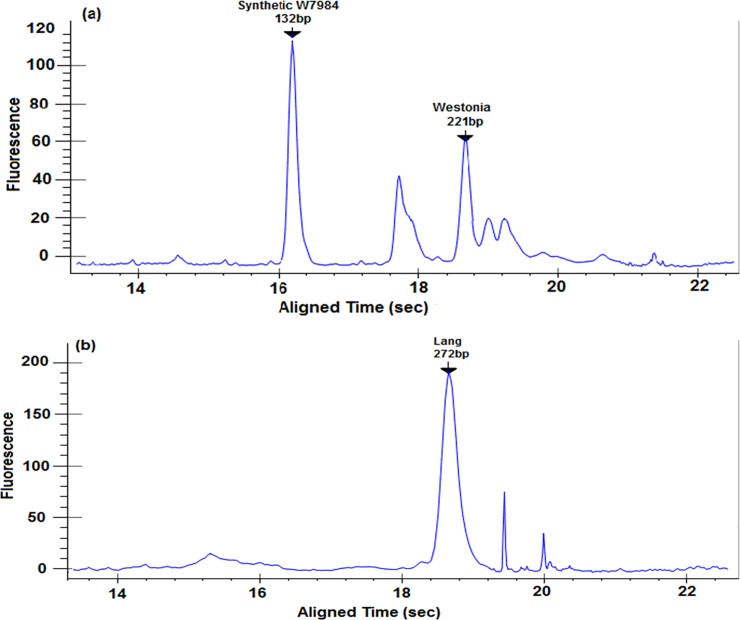
Electropherogram of PCR products of marker Xbarc230 and Xbarc319 from F2:4 Synthetic W7984 × Westonia lines exposed to water stress during meiosis.The calculated molecular weight (bp) of PCR product (peaks) is displayed, the black arrows point to amplified fragment sizes (a) indicates an F2:4 plant with the alleles of both Synthetic W7984 and Westonia parental lines for SSR marker Xbarc230 (b) indicates an F2:4 plant amplified by SSR marker Xbarc319 and possessing the allele of Lang parental line alone.